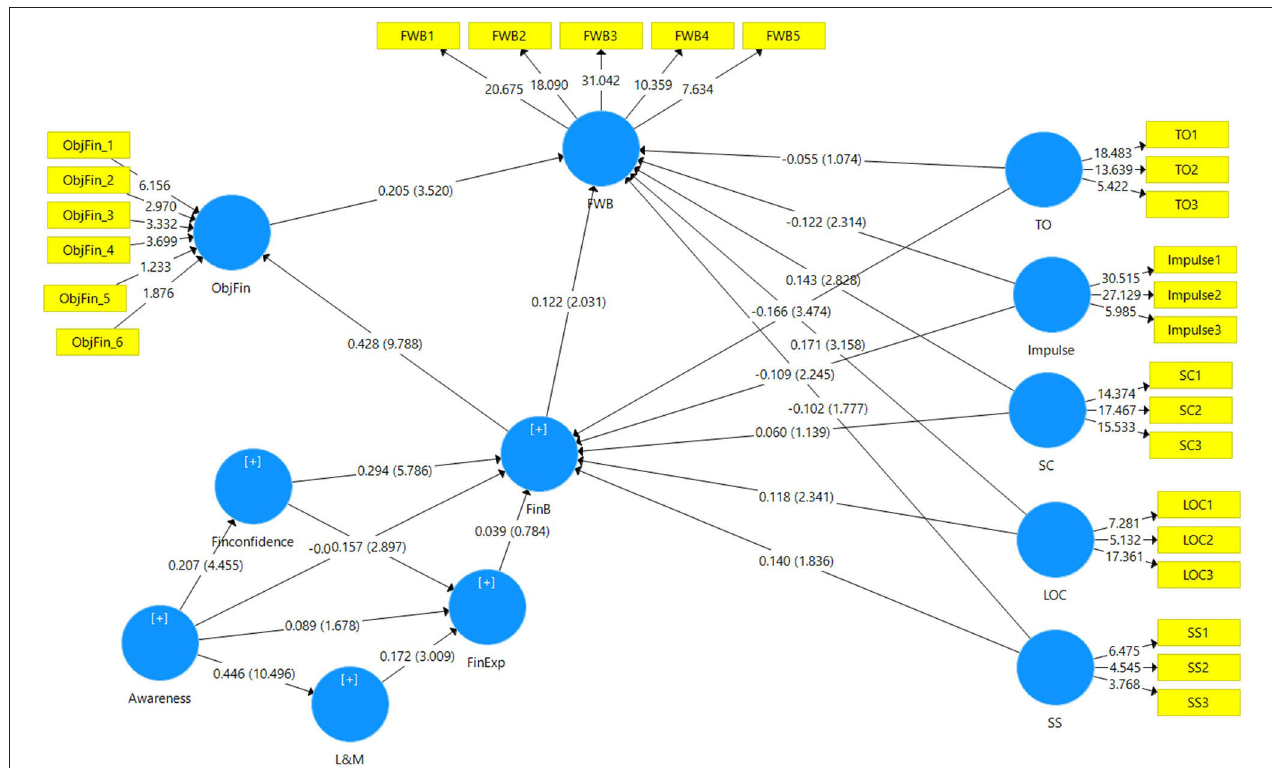
FIGURE 4 | Relevance of the structural model paths. Source: SmartPLS output; In parenthesis is the t -values at 5,000 bootstraps.